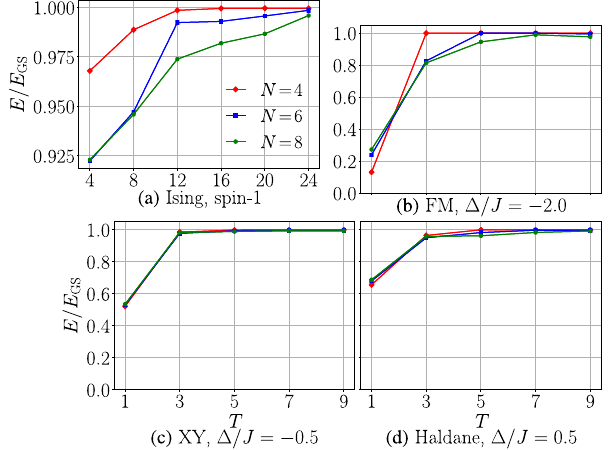
FIG. 21. System-size scaling of the energy minimization against protocol duration T for different system sizes N : (a) Spin-1 Ising chain; (b) – (d) anisotropic Heisenberg spin-1 chain for Δ =J ¼ − 2 . 0 , Δ =J ¼ − 0 . 5 , Δ =J ¼ 0 . 5 , respectively. Note that the y -axis scale is different for the spin-1 Ising model in panel (a). The model parameters are the same as in Figs. 7(a) and 3(b) – 3(d), correspondingly.